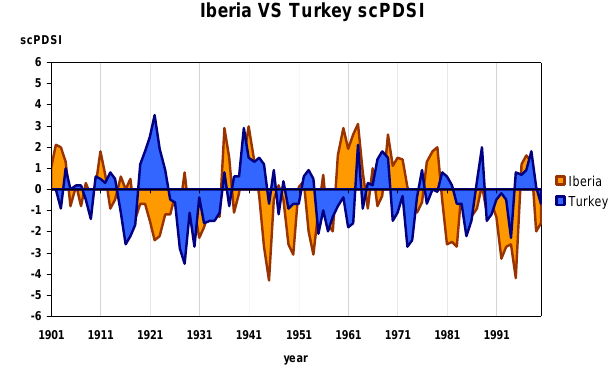
Fig. 7. Comparison between Iberia and Turkey scPDSI series for the 20th